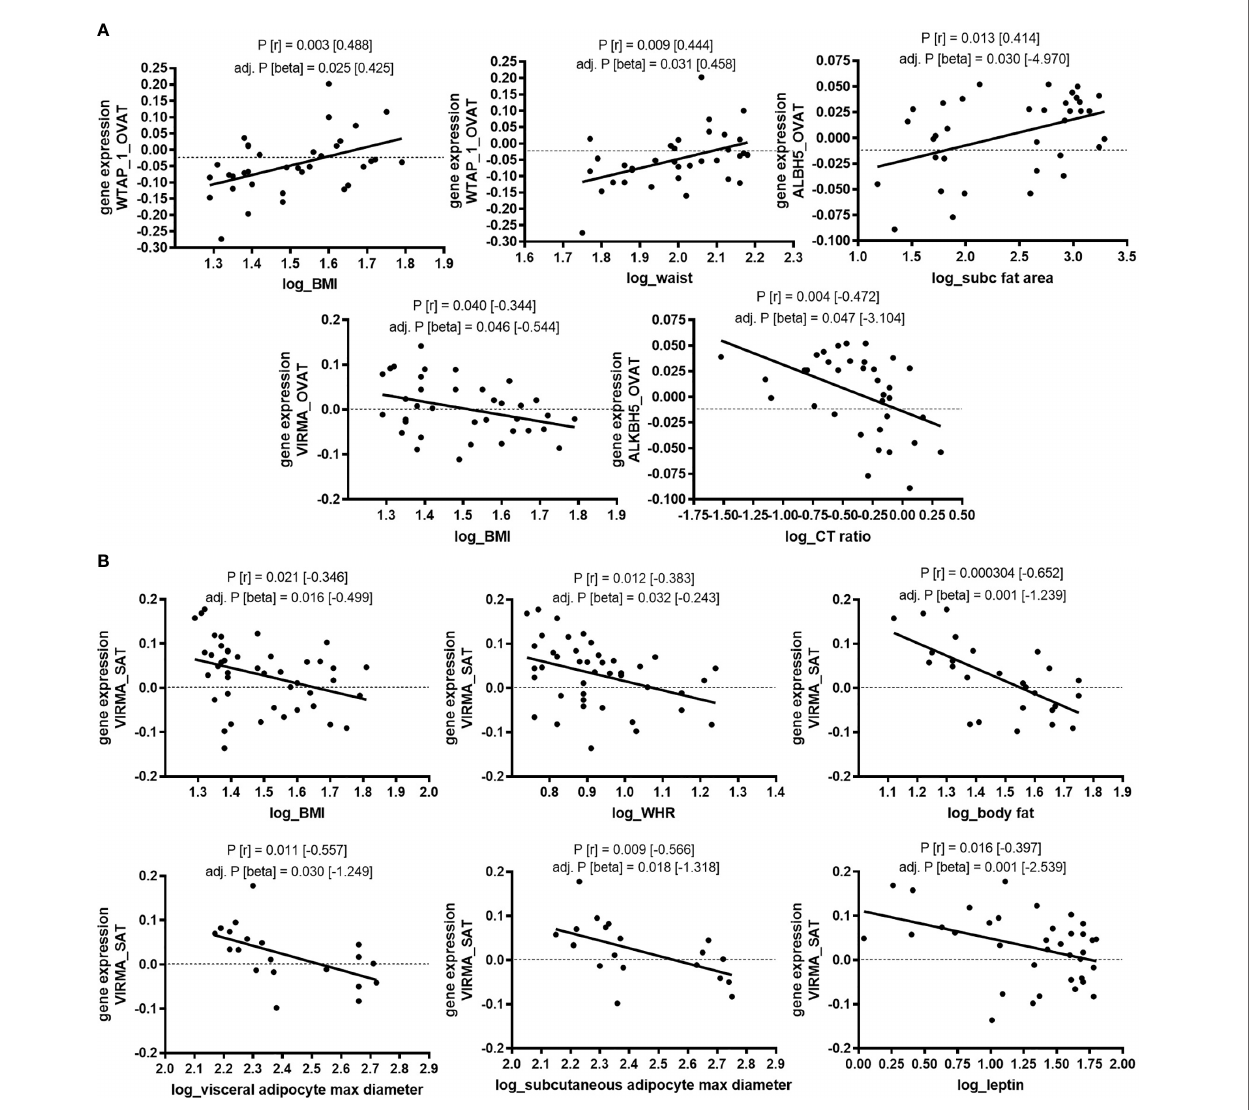
FIGURE 1 | Association of gene expression with clinical variables of obesity and fat distribution in non-diabetic subjects (adipose tissue Leipzig cohort). Correlation of gene expression (log transformed, normalized intensities) with clinical variables of obesity and fat distribution in non-diabetic subjects. (A) in OVAT and (B) in SAT. P -values were calculated by using bivariate Pearson or Spearman correlation. Signi fi cant correlation results are shown for correlations that survive adjustment for age, and sex in linear regression analysis. BMI, body mass index; WHR, waist to hip ratio; OVAT, omental visceral adipose tissue; SAT, subcutaneous adipose tissue; Beta, non-standardized regression coef fi cient from linear regression; P = P -value; r, correlation coef fi cient from bivariate